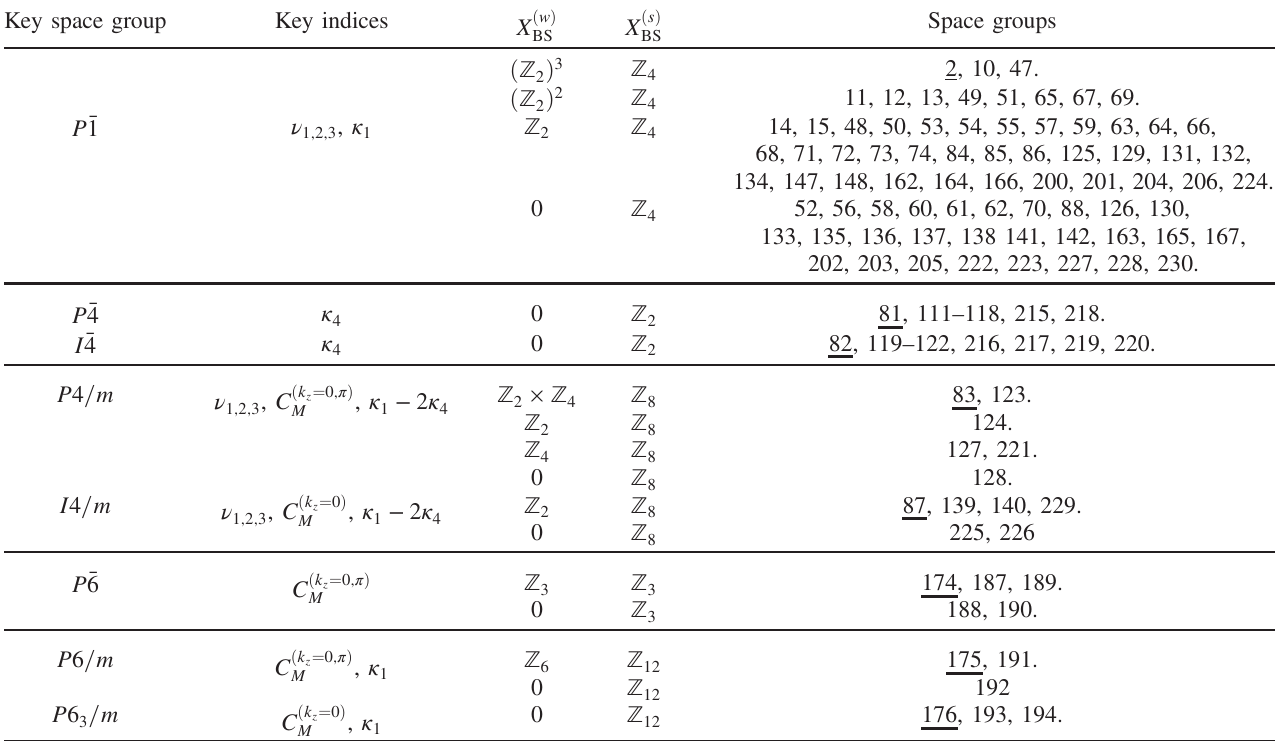
TABLE I. Summary of symmetry-based indicator of band topology. Space groups are grouped into their parental key space group in the first column. The second column lists the key topological indices characterizing nontrivial classes in X indicated by their numbers assigned in Ref. [45], and those highlighted by an underbar are the key SGs. Key space group Key